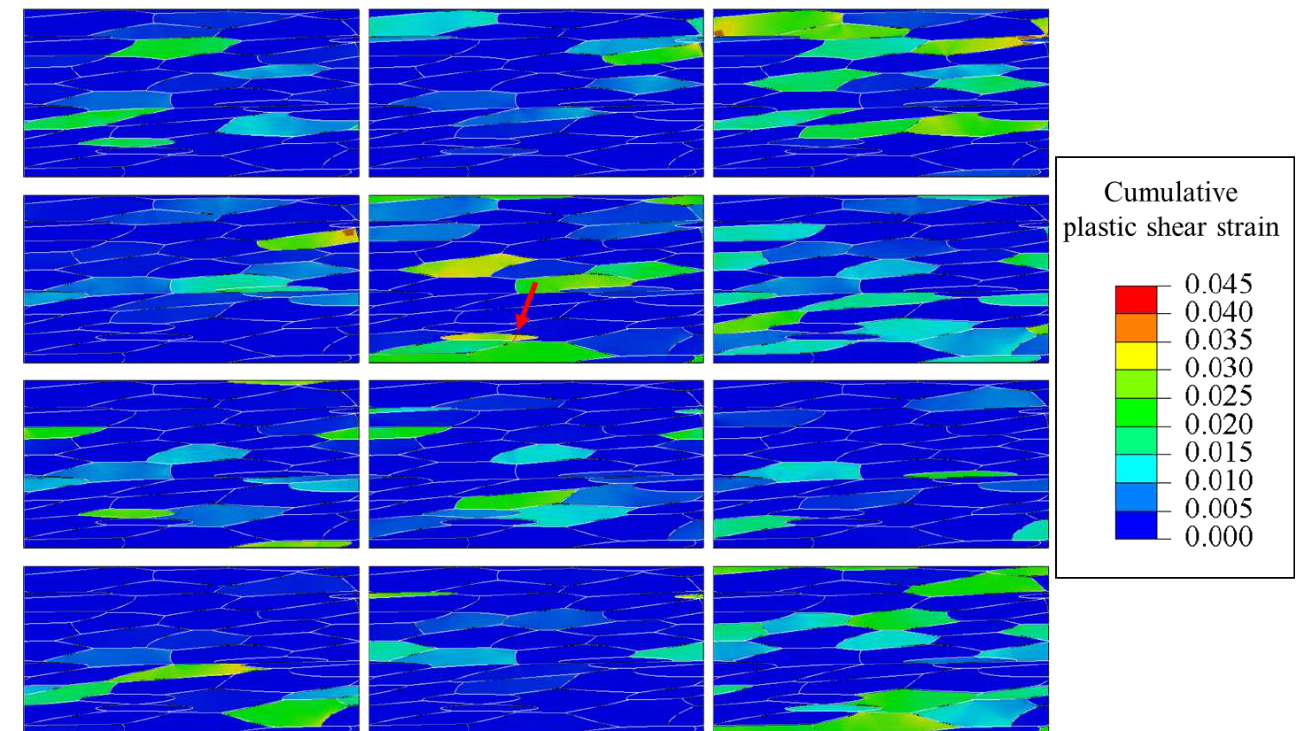
Figure 5. Distribution of cumulative plastic shear strain for 12 slip systems in the last calculation step ( σ max = 340 MPa, R = −1). The predicted crack initiation site is indicated by an arrow and a red solid line.